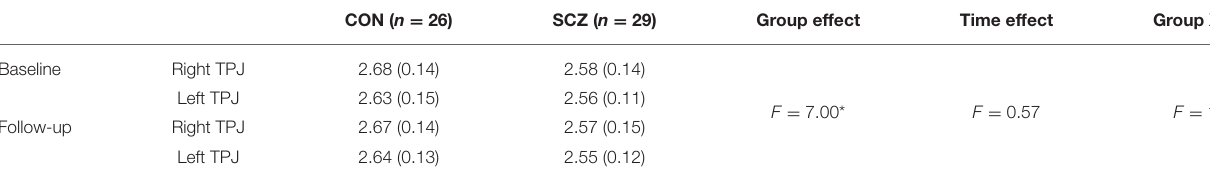
TABLE 2 | Means (standard deviations) of TPJ thickness (mm) in controls and schizophrenia participants at baseline and follow-up.